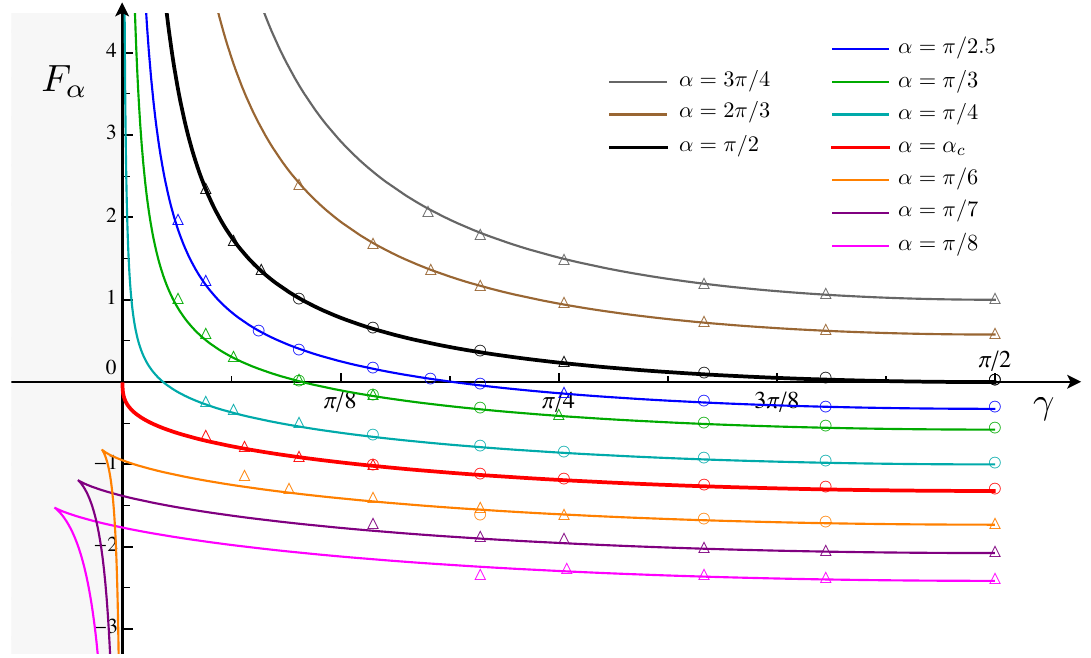
Figure 14 . The corner function F (cid:11) ( (cid:13) ) for some values of the slope (cid:11) of the half plane Q . The solid curves are obtained from the analytic expressions (6.5) and (6.10), which provide the corner function parametrically in terms of q 0 > 0 (see also (cid:12)gure 15). The marked points have been found through our numerical analysis based on Surface Evolver. The empty circles label the data points obtained from the domain A in (cid:12)gure 12, while empty triangles label the data points found by employing the domain A in (cid:12)gure 13. The same color has been adopted for the analytic curves and the data points corresponding to the same (cid:11)